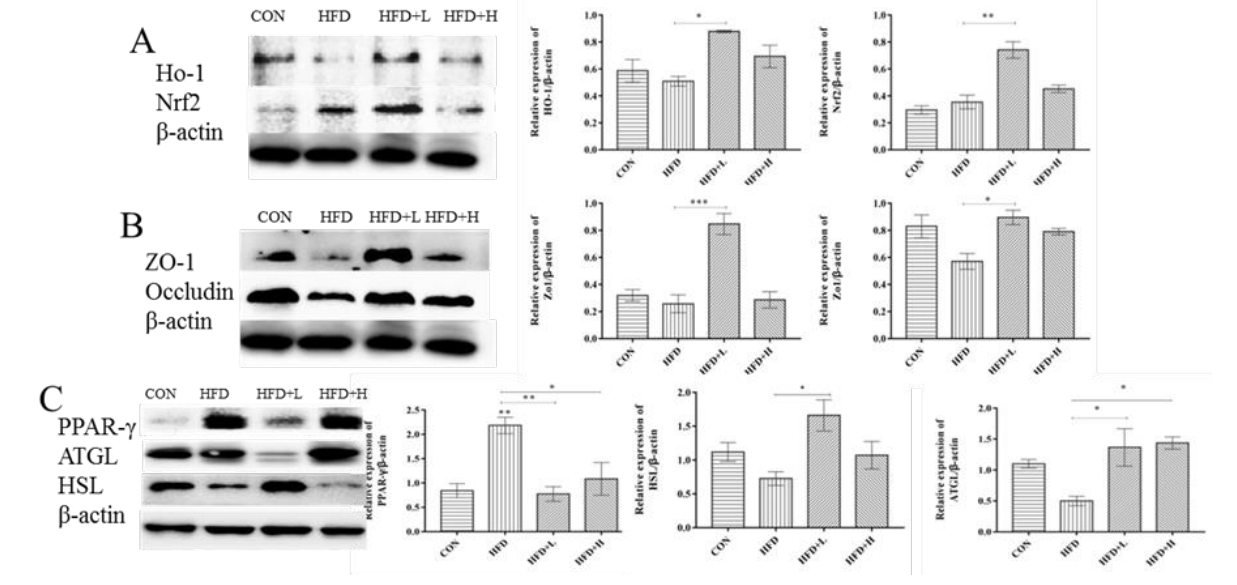
Figure 7. Effect of CIP on protein expression ( n = 2~3). ( A ) Densitometric quantification and Western blot analysis of HO-1 and Nrf2; ( B ) densitometric quantification and Western blot analysis of ZO-1 and Occludin; ( C ) densitometric quantification and Western blot analysis of PPAR- γ, ATGL, and HSL. Data were shown as mean ± SEM. * p < 0.05, ** p < 0.005 and *** p < 0.001 compared with the other groups.